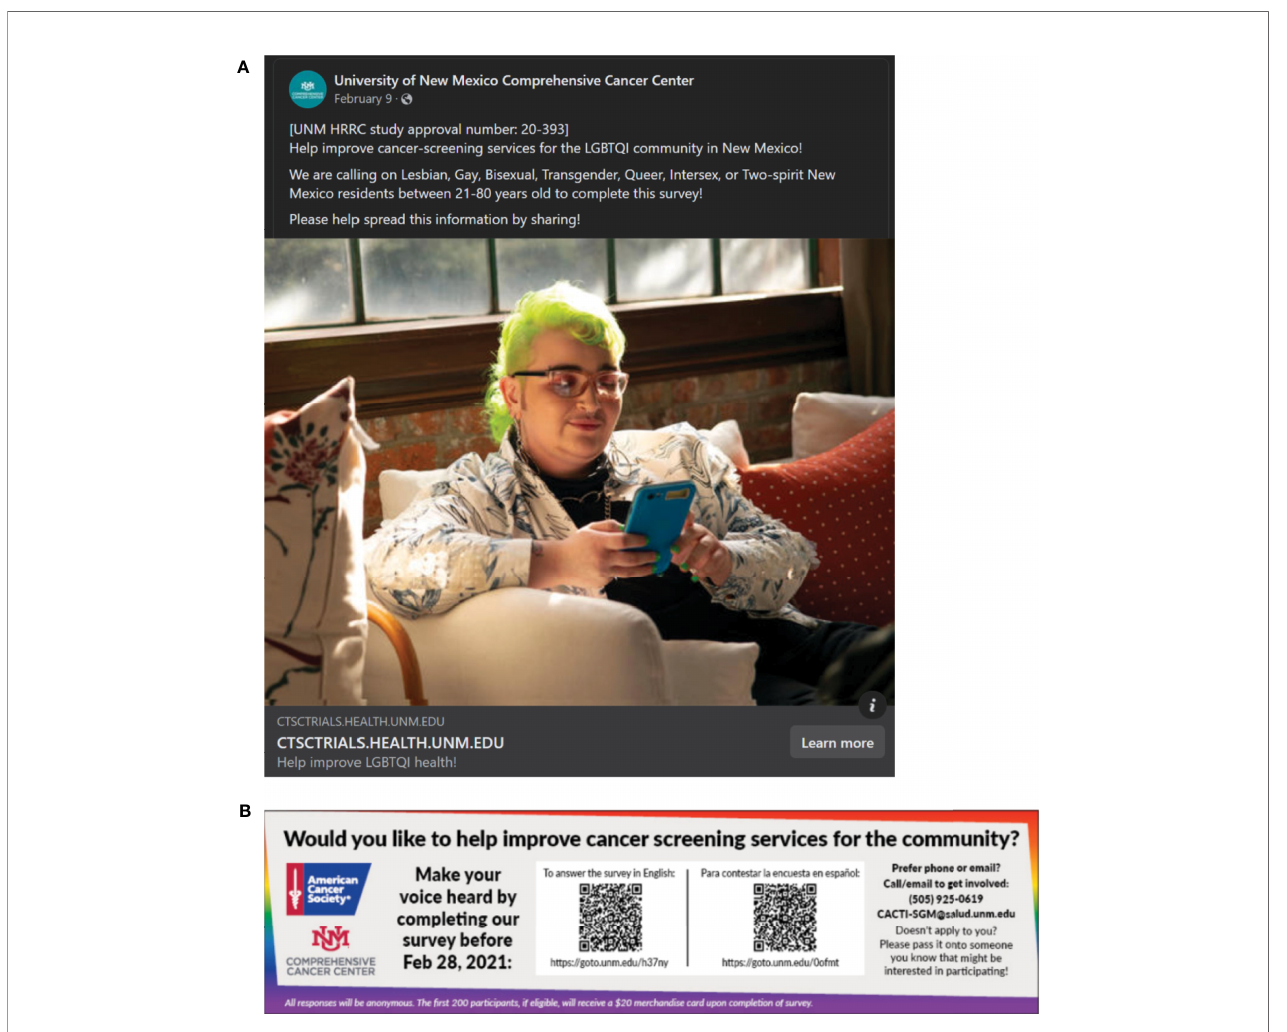
FIGURE 3 | Facebook (A) and Google (B) ads created for the